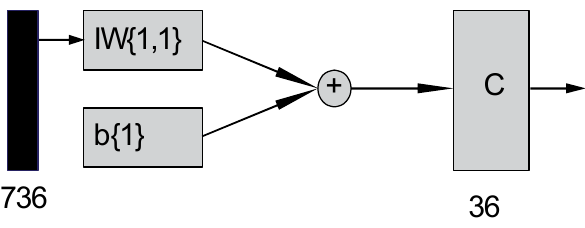
Fig. 3. A Kohonen Network built to classify a vector of 736 members into 36 clusters. The input vector is directed to the input weight matrix (IW{1,1}). The result is forwarded with the biases (b{1}) to the network which classifies the input vector accordingly.